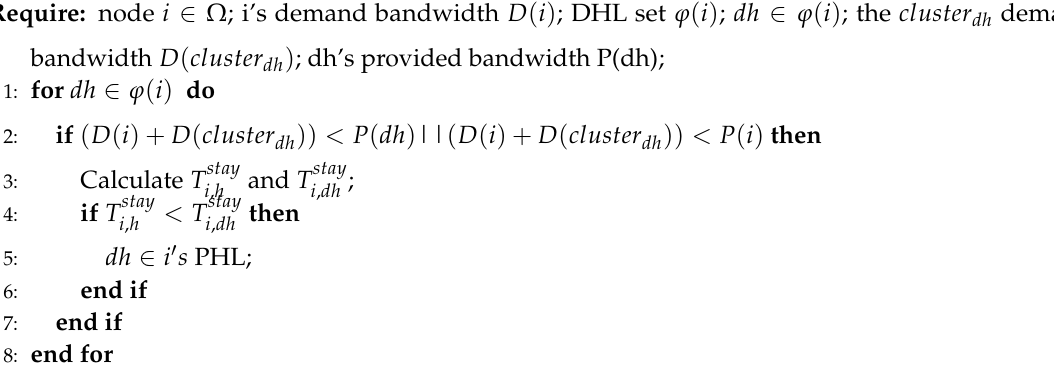
Algorithm 3 Find potential heads